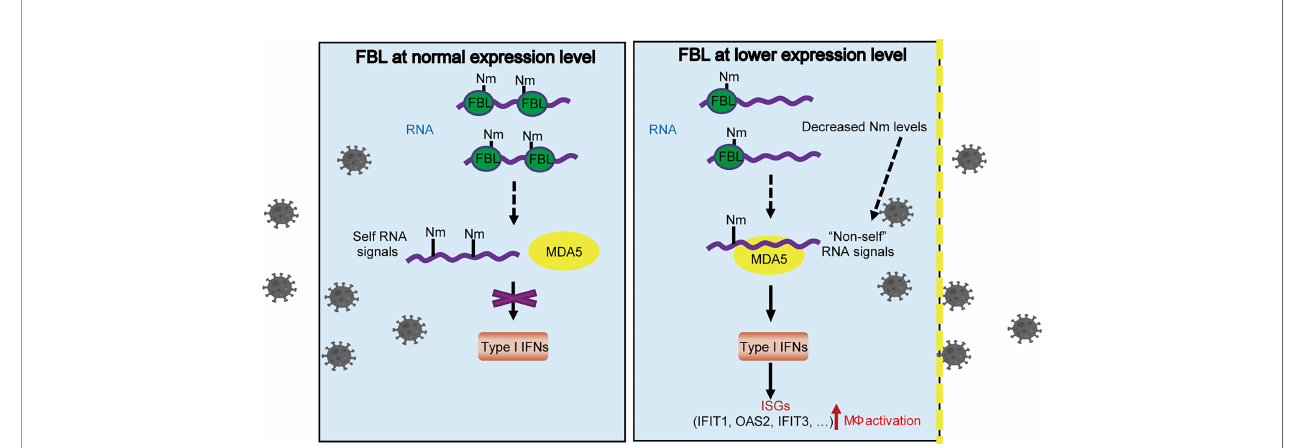
FIGURE 8 | A proposed model for FBL-mediated RNA 2 ’ -O methylation in promoting viral entry into macrophages by inhibiting MDA5-mediated IFN-I and ISGs expression. FBL directly catalyzes the formation of Nm RNA modi fi cations. When FBL is expressed at a low level, the RNA with decreased Nm modi fi cation levels may be recognized as “ non-self ” RNAs by MDA5, which promotes the expression of IFN-I at the steady state, and then induces the expression of antiviral ISGs, such as IFIT1, OAS2, IFIT3 and so on. This “ Primed immune activated state ” in macrophages, upon FBL is inhibited in response to viral infection, contributes to blockade of the viral